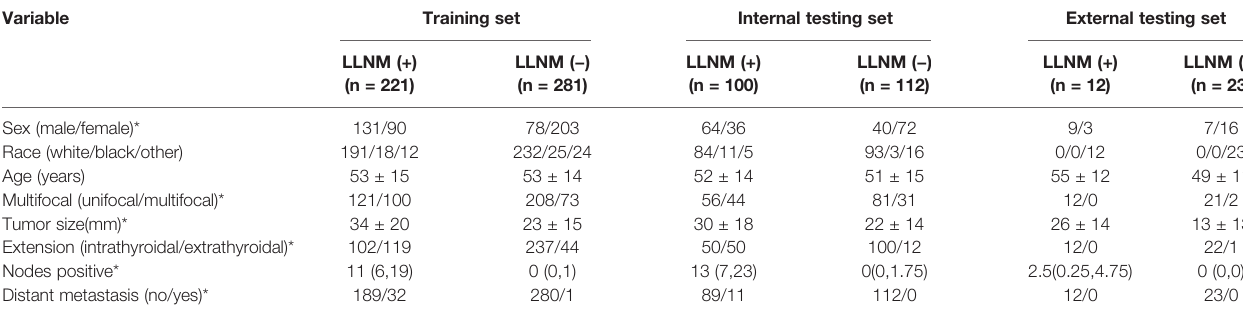
TABLE 1 | Clinicopathological characteristics of MTC patients.